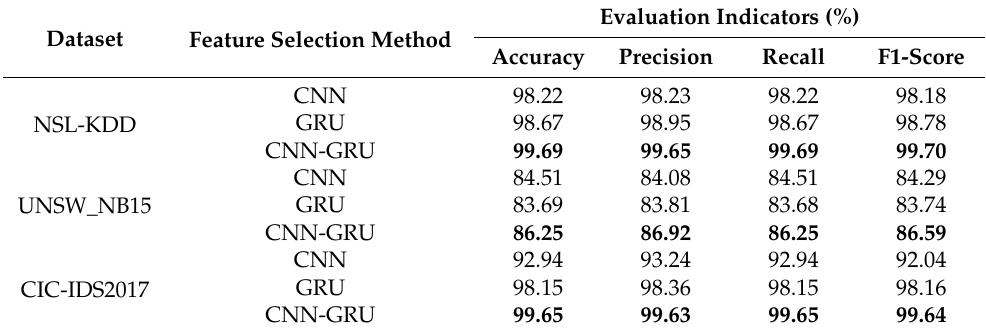
Table 9. Comparison of single and hybrid